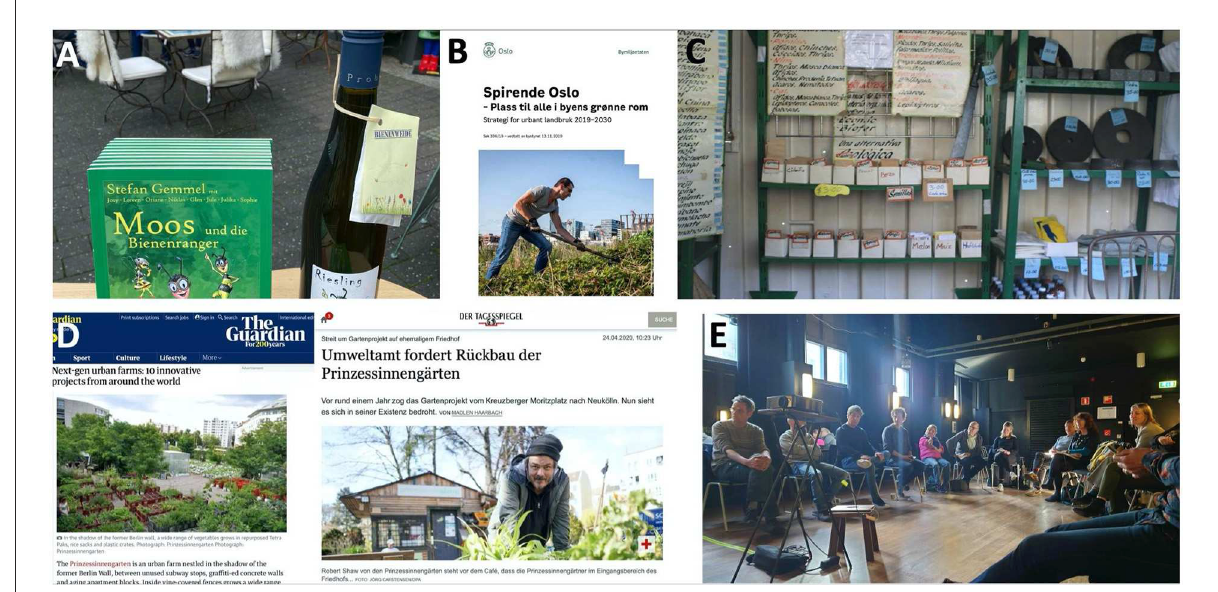
FIGURE3 Best scaling practices from Andernach (A) , Oslo (B) , Havana (C) , Berlin (D) , and Rotterdam (E) . For details see section 3.2.